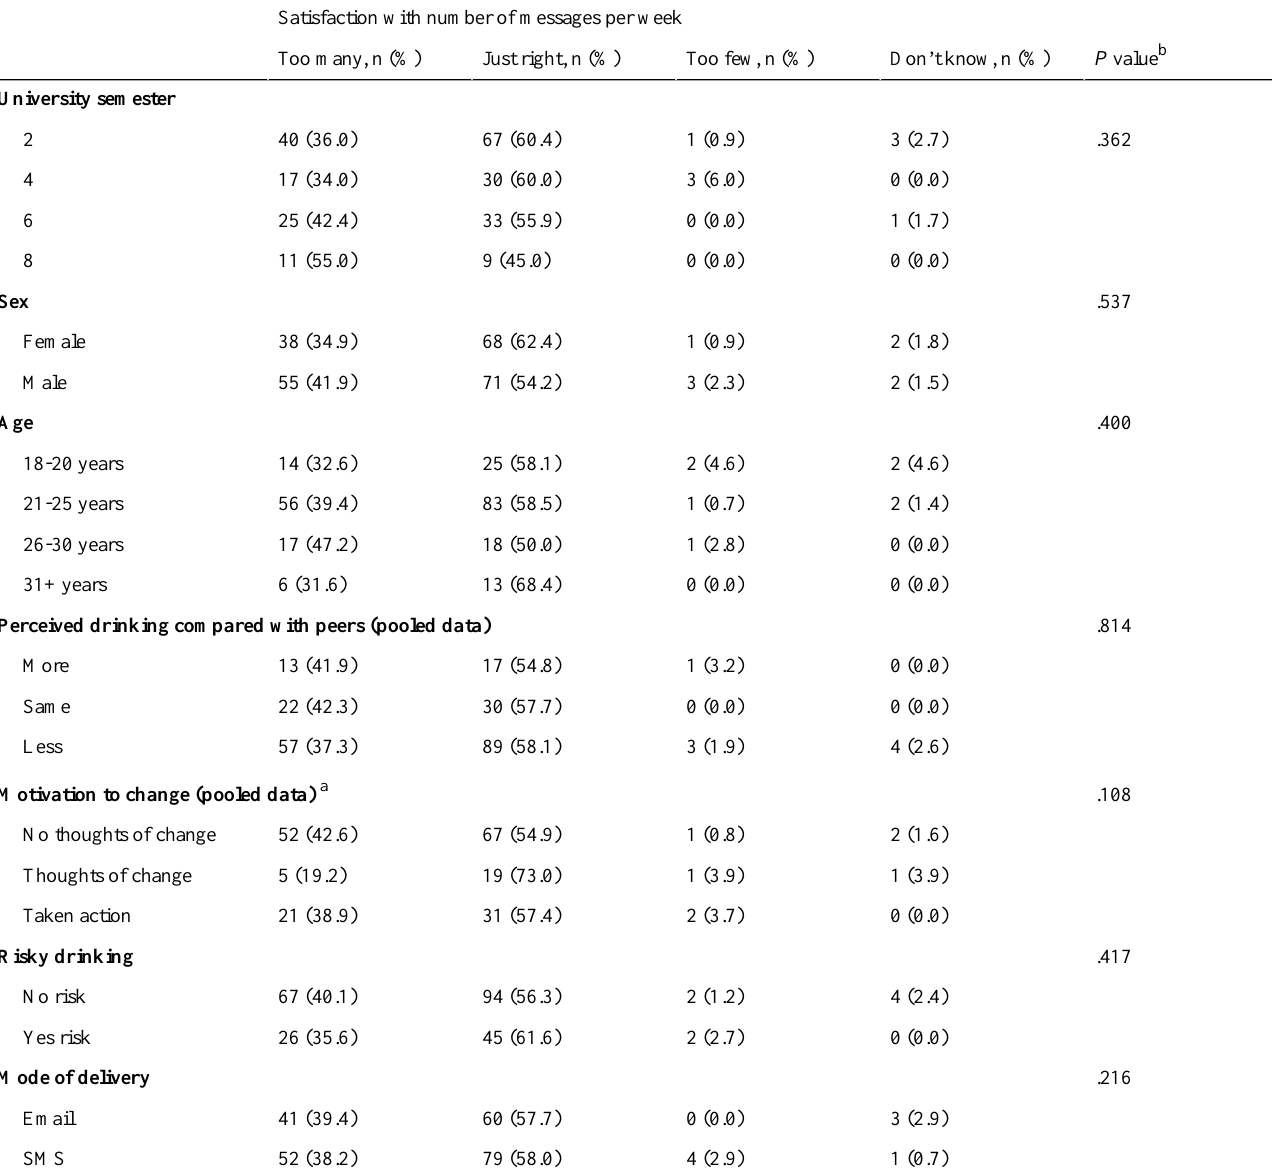
Table 4. Satisfaction with the number of messages per week in relation to background characteristics. Satisfaction with number of messages per